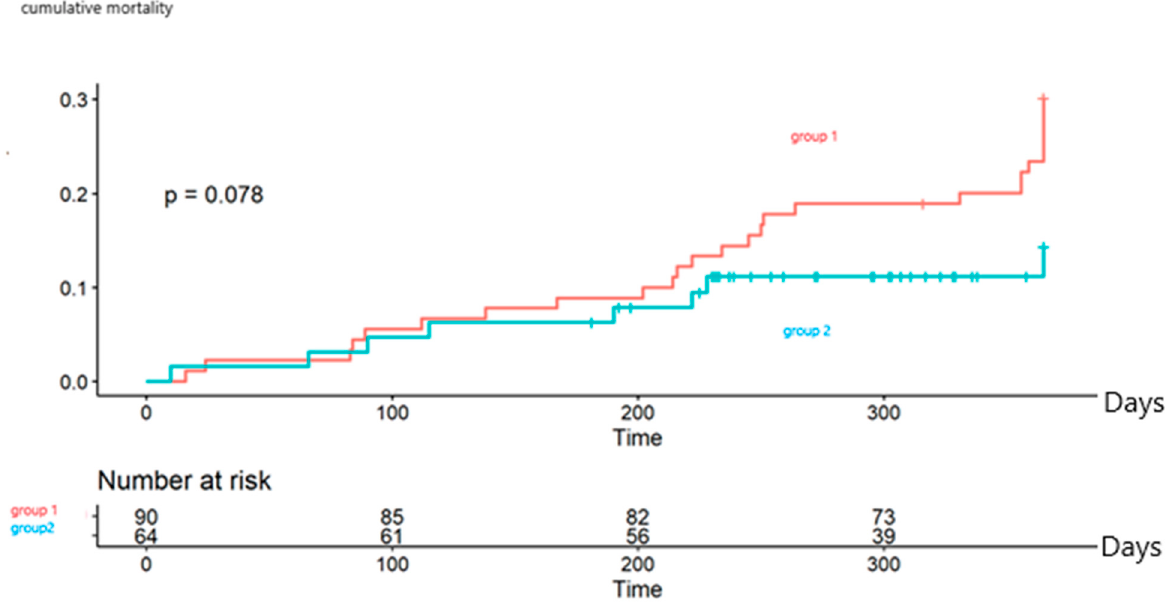
Figure 3. Cox cumulative analysis of mortality at 1 year. No statistical significance was noticed.